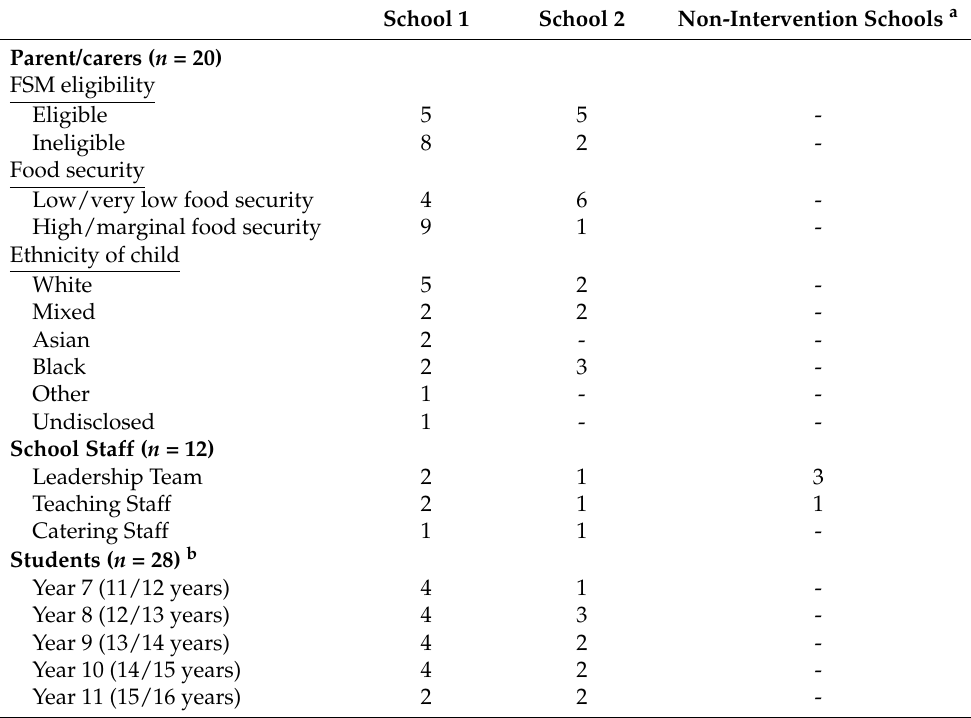
Table 2. Characteristics of interview participants ( n = 60).